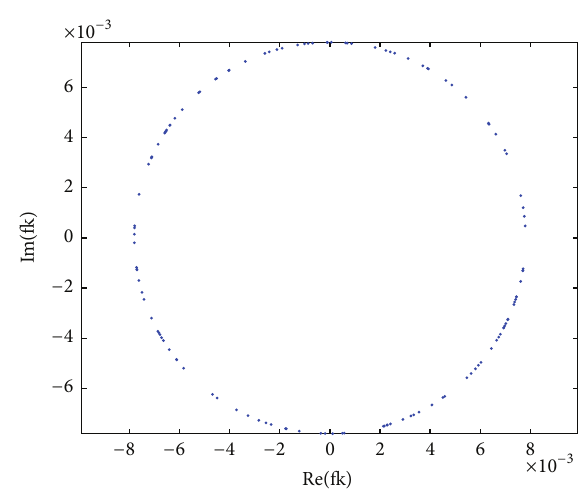
Figure 4: Target spectrum and clutter spectrum.